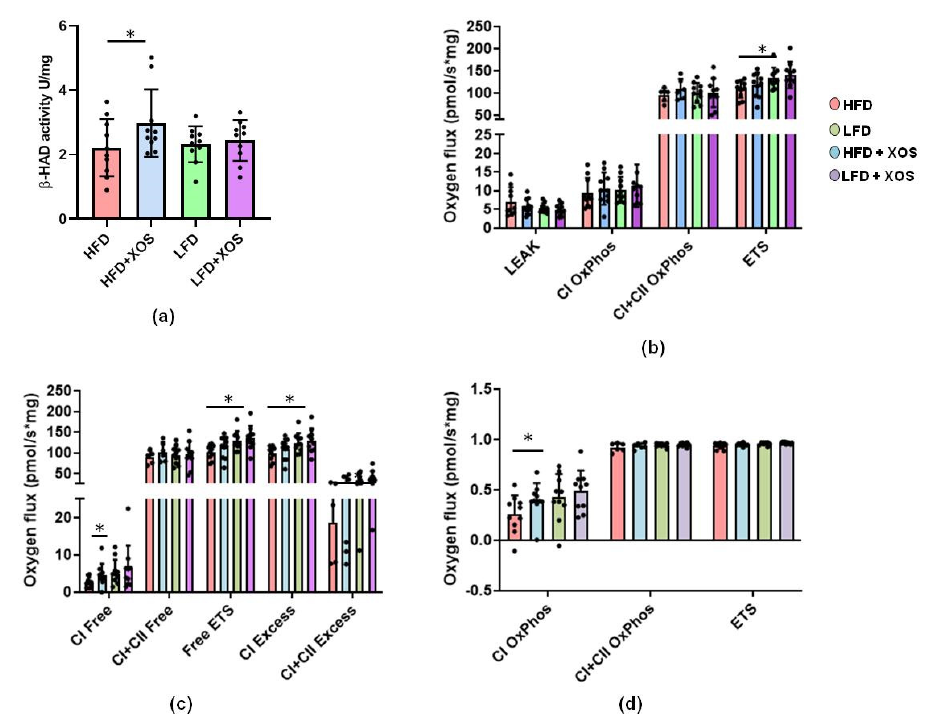
Figure 3. XOS enhanced the hepatic activity of fatty acid-oxidating beta-hydroxydeacetylase dehydrogenase ( β -HAD) on the HFD and also increased mitochondrial respiration, reflecting increased glucose metabolism. ( a ) The biochemically measured activities of β -HAD in rat livers. n = 8–10/diet group; ( b ) HFD lowered maximal electron transport (ETS) in liver mitochondria. n = 8–10/diet group; ( c ) HFD lowered maximal electron transport capacity available for oxidative phosphorylation (Free ETS), reserve electron transport capacity beyond oxidative phosphorylation through complex I (CI Excess) as well as through complexes I and II (C+CII Excess). On the HFD, XOS increased the respiratory capacity available for the production of ATP through the electron flow from complex I (CI Free). n = 8–10/diet group; ( d ) On the HFD, XOS improved coupling of electron transport through the complex I and oxidative phosphorylation (CI OxPhos, coupling efficiency). n = 8–10/diet group. In all graphs, the different data points are shown with black dots. * indicates statistically significant difference between the groups in all graphs. The HFD decreased but XOS had no effects on the hepatic mRNA expression of SCD1 (effect of diet: F (1,36) = 97.5, p < 0.001) and DGAT2 (effect of diet: F (1,35) = 8.7, p = 0.006), which are involved in lipogenesis and the synthesis of triglycerides, respectively (Figure 4).